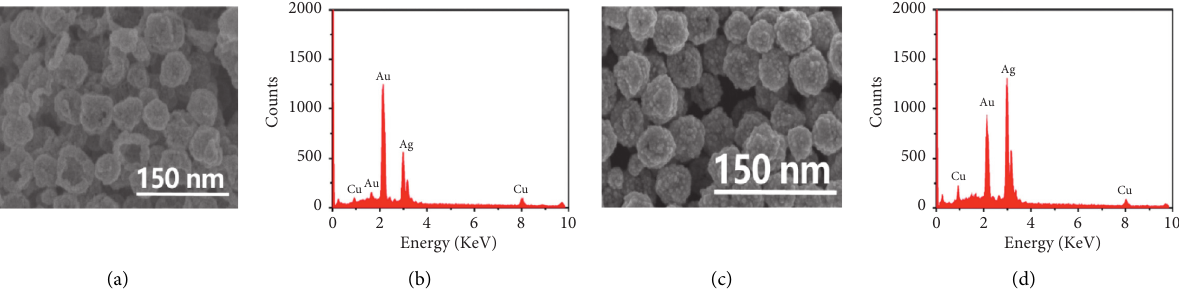
Figure 4: SEM and EDX images of product obtained with conventional etching agent: (a) SEM image; (b) EDX image; (c) SEM image; (d) EDX image.